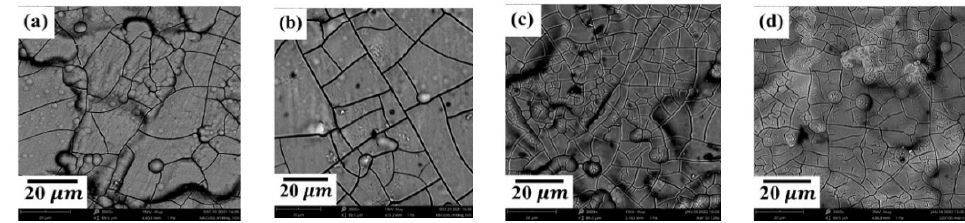
Figure 4. The 30 s chromium conversion treatment, 3000 diameter SEM surface images of Zn–Ni flakes at different NaF concentrations: ( a ) NaF 0%, ( b ) NaF 50%, ( c ) NaF 100%, and ( d ) NaF 150%.